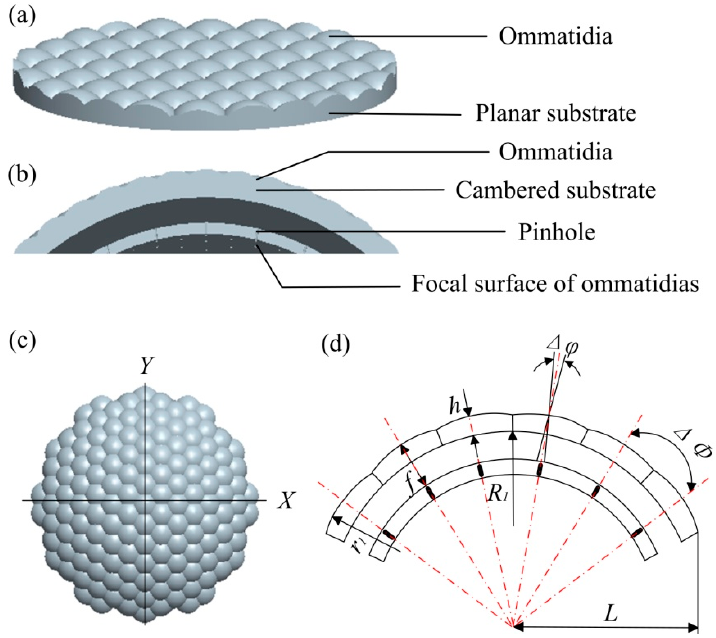
Figure 1. Original model of the microlens and compound eye: ( a ) the 3D model of ordinary curved microlens arrays; ( b ) the cross section of the compound eye; ( c ) the top view of compound eye; ( d ) the 2D structure of compound eye along the X direction in Figure 1c.